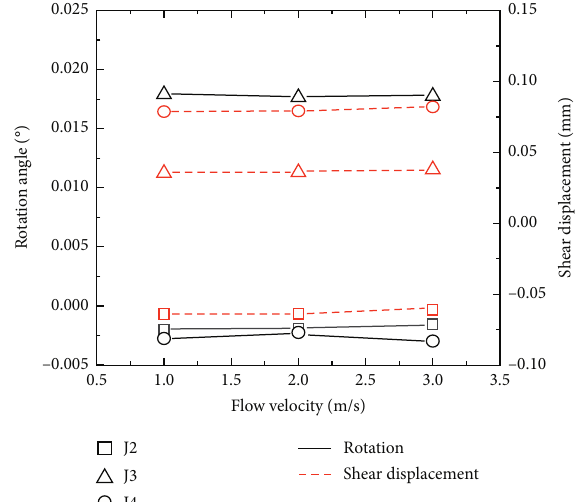
Figure 13: Influence of flow velocity on joint rotation and shear displacement.